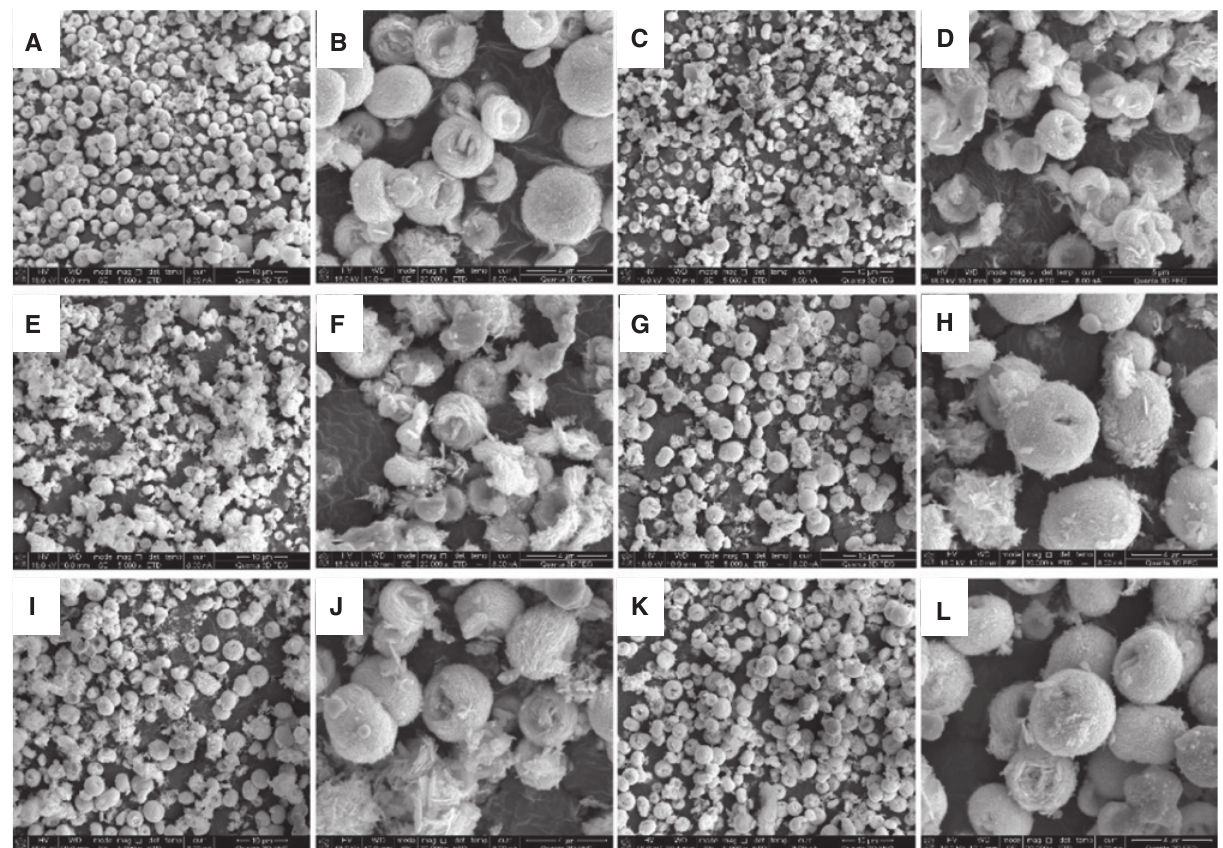
= 2‰; (E) R = 4‰; (G) R = 6‰; (I) R = 8‰; (K) M M M M